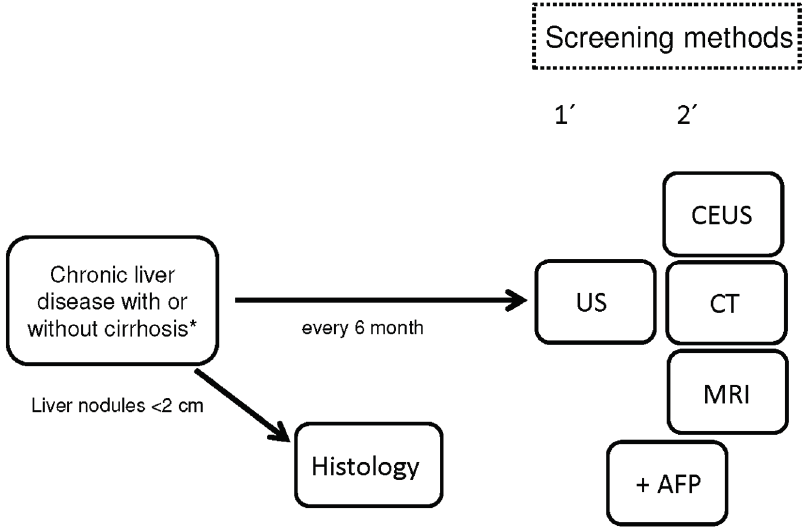
Figure 1. Screening test in patients with chronic liver disease or cirrhosis according to the German S3 guideline. AFP: alpha-fetoprotein, CEUS: contrast-enhanced ultrasound, CT: computer tomography, MRI: magnetic resonance imaging, US: ultrasound. * No patients with CHILD-Pugh Score